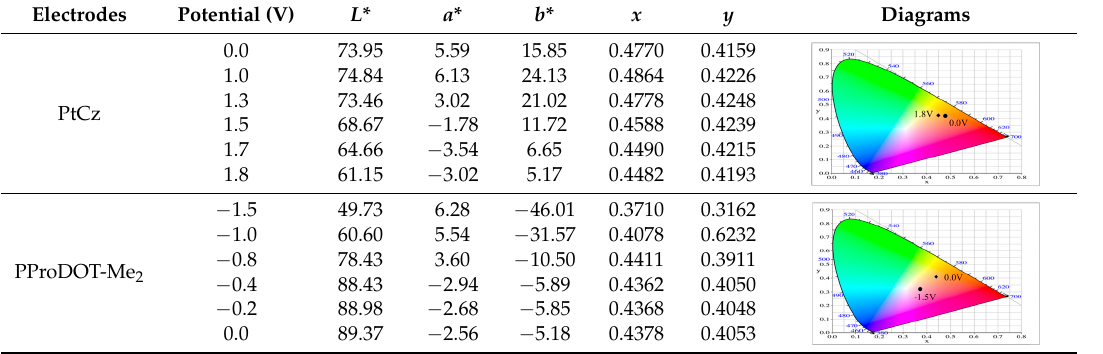
Figure 5. UV-Visible spectra of ( a ) PtCz and ( b ) PProDOT-Me 2 on ITO in an ACN/DCM (1:3, by volume) solution containing 0.2 M LiClO 4 . Table 2. Colorimetric values ( L *, a *, and b *), CIE chromaticity values ( x , y ), and CIE chromaticity diagrams of the PtCz and PProDOT-Me 2 at various applied potentials.